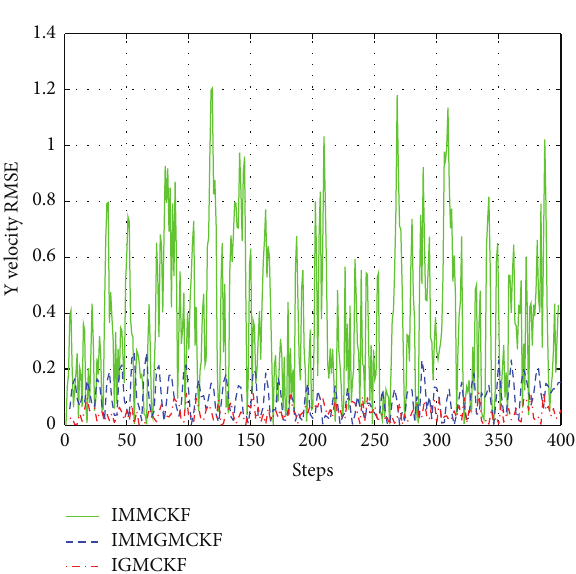
Figure 9: X position RMSE.